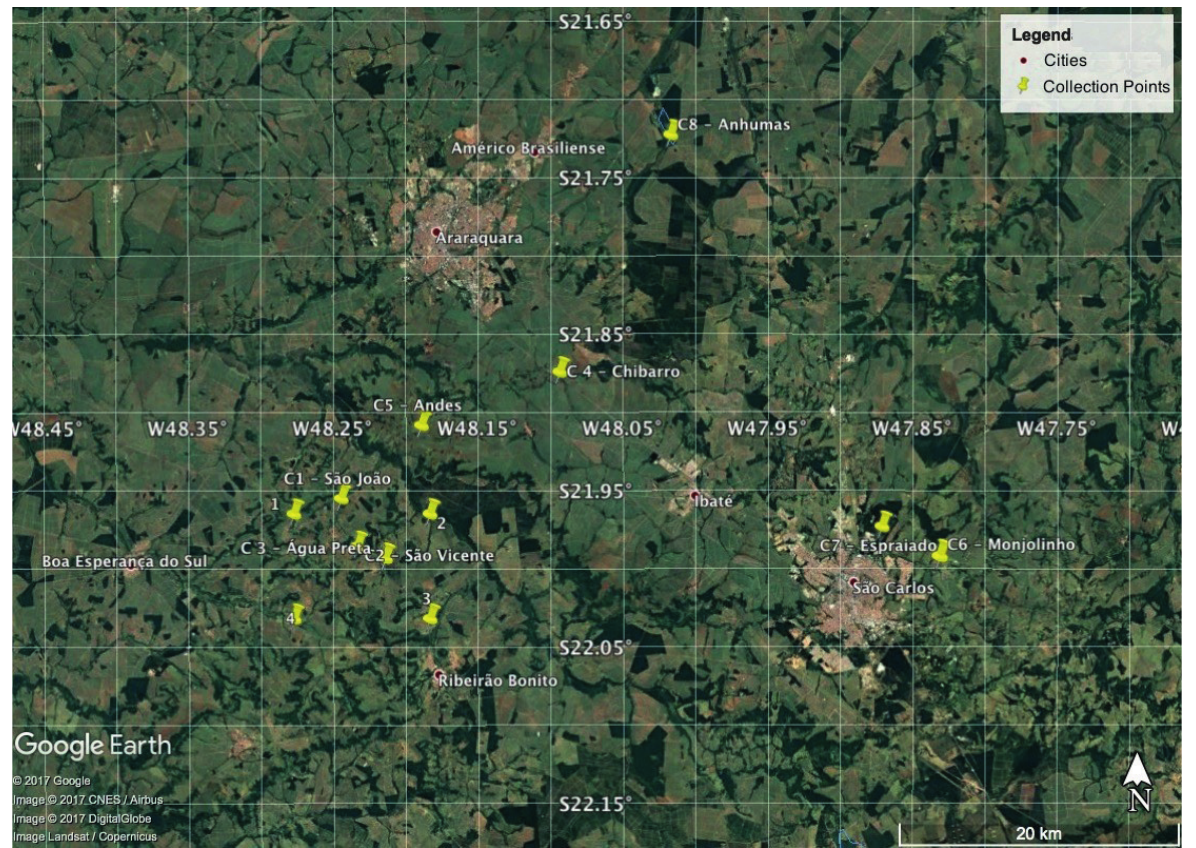
Figure 1 - Location of the eight sampling sites, State of São Paulo, Brazil. Streams C1 to C5 are located in sugarcane cultivation areas. Strems C6 to C8 are located in preserved areas. Streams detailed information in Table